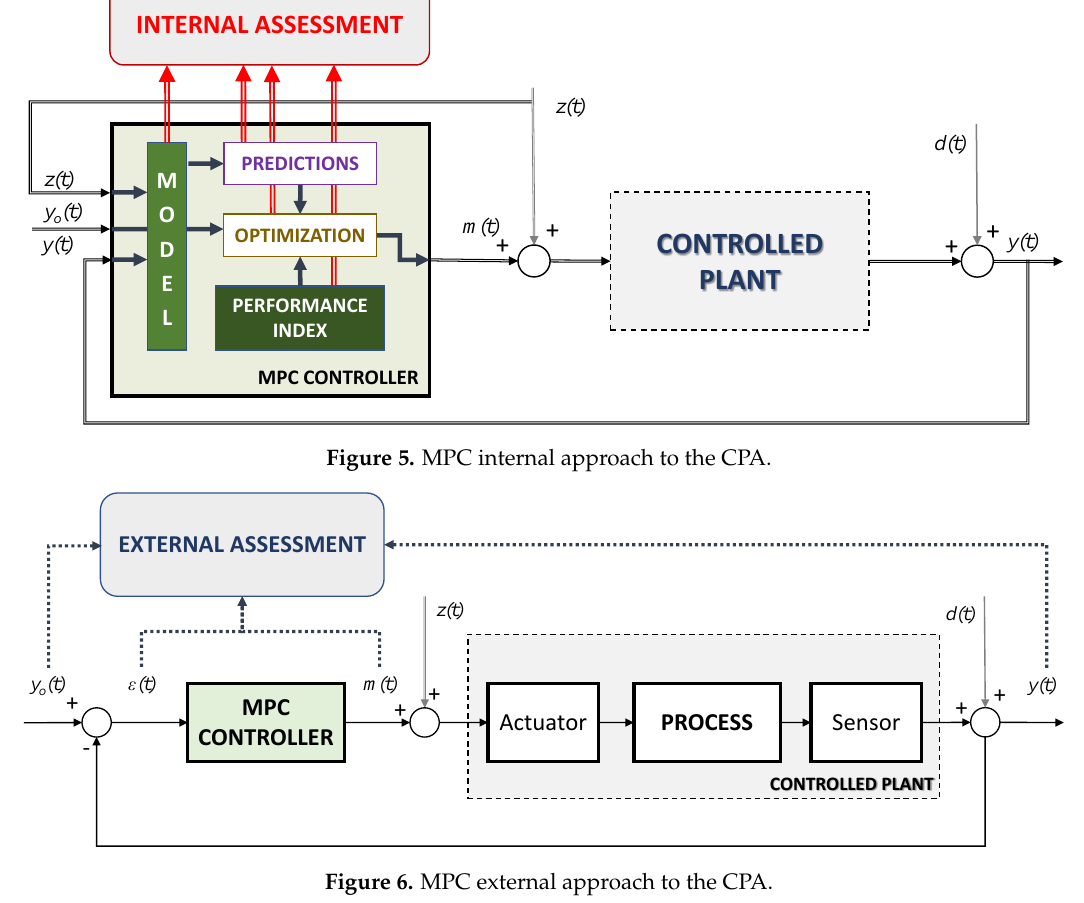
Figure 6. MPC external approach to the